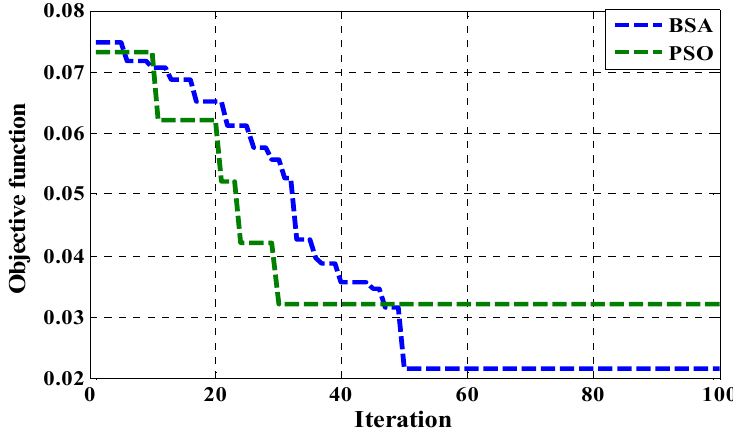
Figure 11. Performance comparison based on BSA and particle swarm optimization (PSO). Table 4. Values of output error by different techniques.